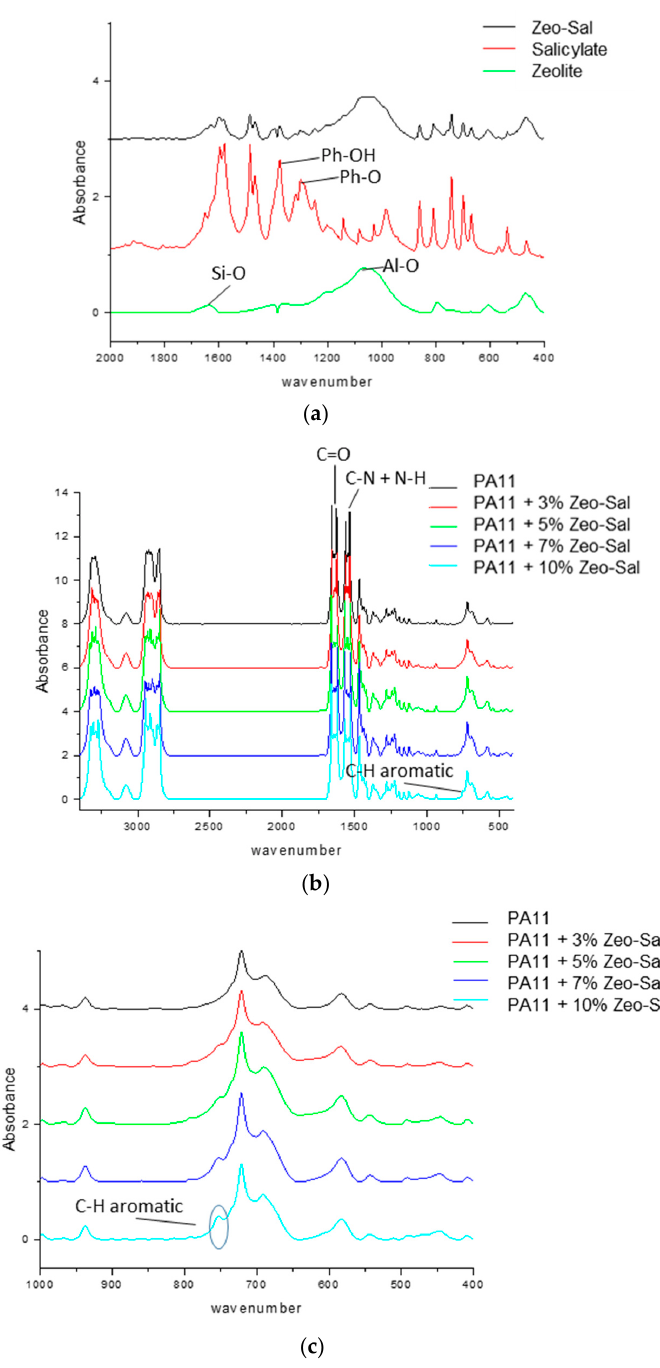
Figure 6. FTIR spectra. ( a ) Salicylate, zeolite, and zeolite-salicylate hybrid; ( b ) and ( c ) unfilled PA11 and composite materials (PA11 + Zeo-Sal).